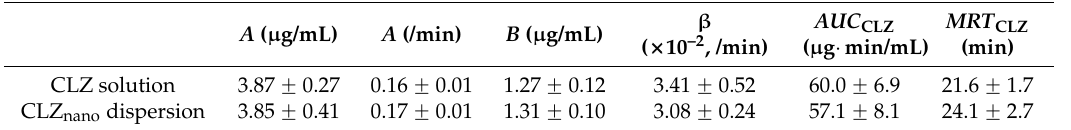
Figure 3. Changes in plasma CLZ concentration after intravenous injection of CLZ solution or Table 3. Pharmacokinetic parameters of plasma CLZ concentration after intravenous injection of CLZ CLZ nano dispersion. 0.3 mL of CLZ solution (open circles) or CLZ nano dispersion (closed circles) was solution and CLZ nano injected into the femoral vein (0.1 mg/kg), and venous blood (200 μ L) was collected. Solid lines present fitting curves for plasma CLZ fates after intravenous administration of CLZ solution or CLZ nano dispersion. The data are presented as means ± S.E. of seven independent rats.